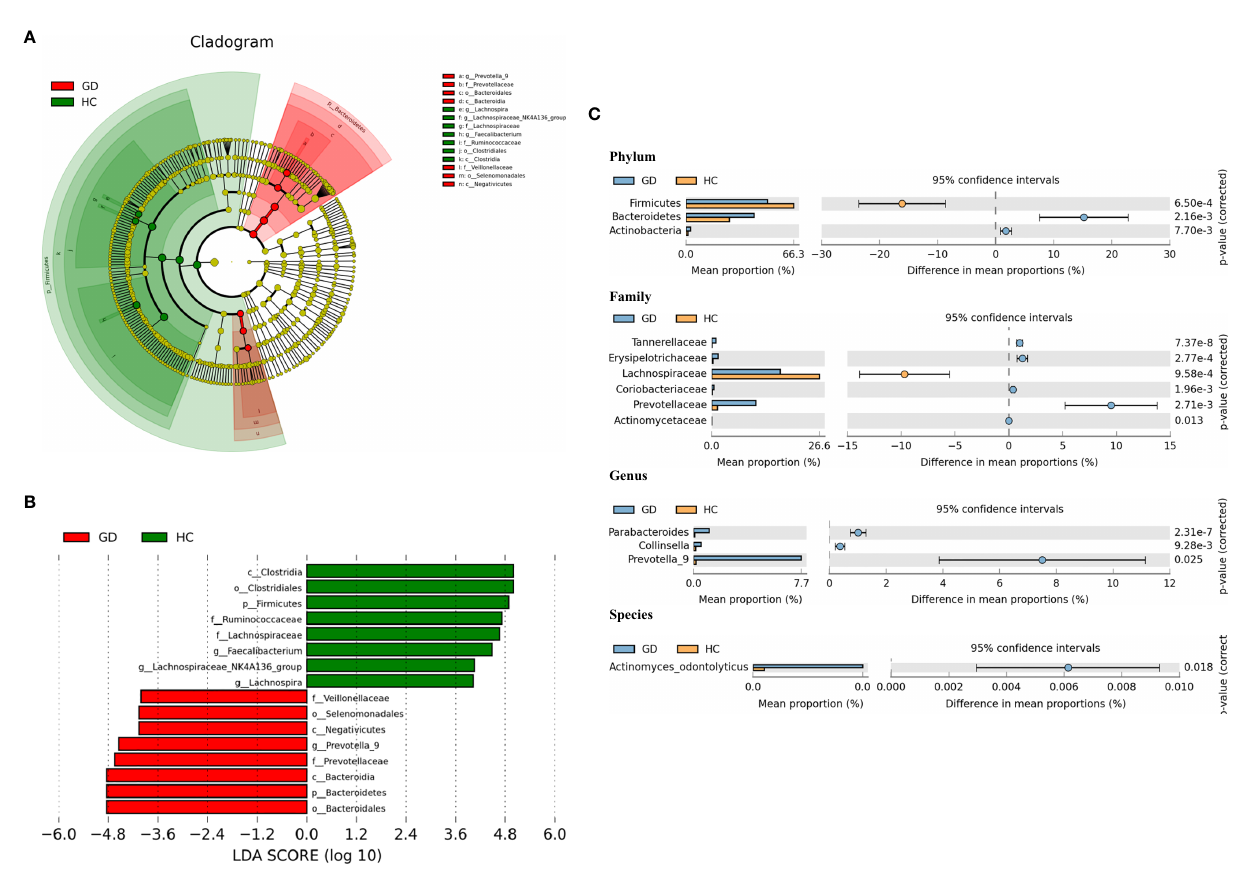
FIGURE 2 | Taxonomic cladogram plotted from linear discriminant analysis (LDA) effect size (LEfSe) analysis and statistical analysis of metagenomic pro fi les (STAMP) analysis. Linear discriminant analysis effect size (LEfSe) analysis shows bacterial taxa signi fi cantly enriched in the GD (red) or healthy controls (HC, green) groups. Taxonomic cladogram and linear discriminant analysis (LDA) scores show differences among taxa between GD and healthy controls. Only taxa meeting a signi fi cant LDA threshold value of >4 are shown (A, B) . Differentially abundant taxa from the phylum to genus level were further analyzed by STAMP analysis using Welch ’ s t - test ( p < 0.05, q < 0.05) (C)